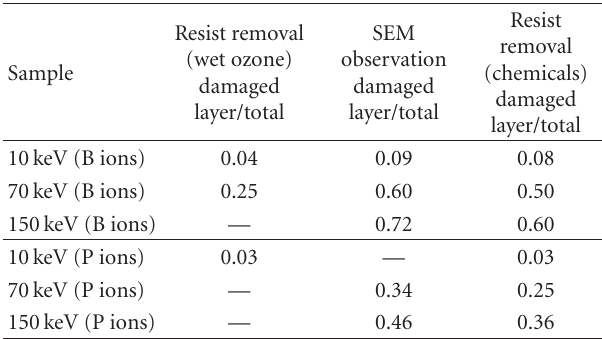
Table 4: Percentages of ion-implanted resist damaged layer by SEM and stripping of ion-implanted resist using